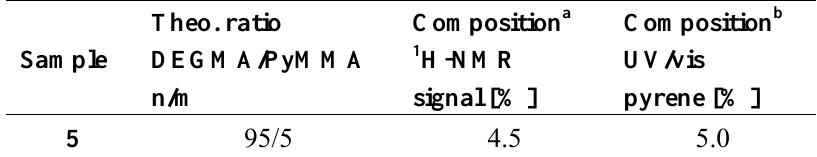
Table 2. Composition of poly(DEGMA- stat